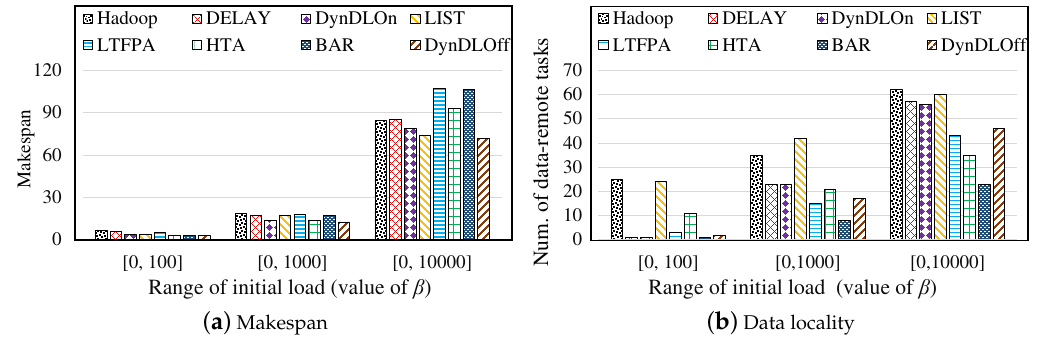
Figure 5. Effects of initial loads. LIST: list scheduling; LTFPA: Local-Tasks-First Priority Algorithm; HTA: Algorithm for Hadoop Task Assignment